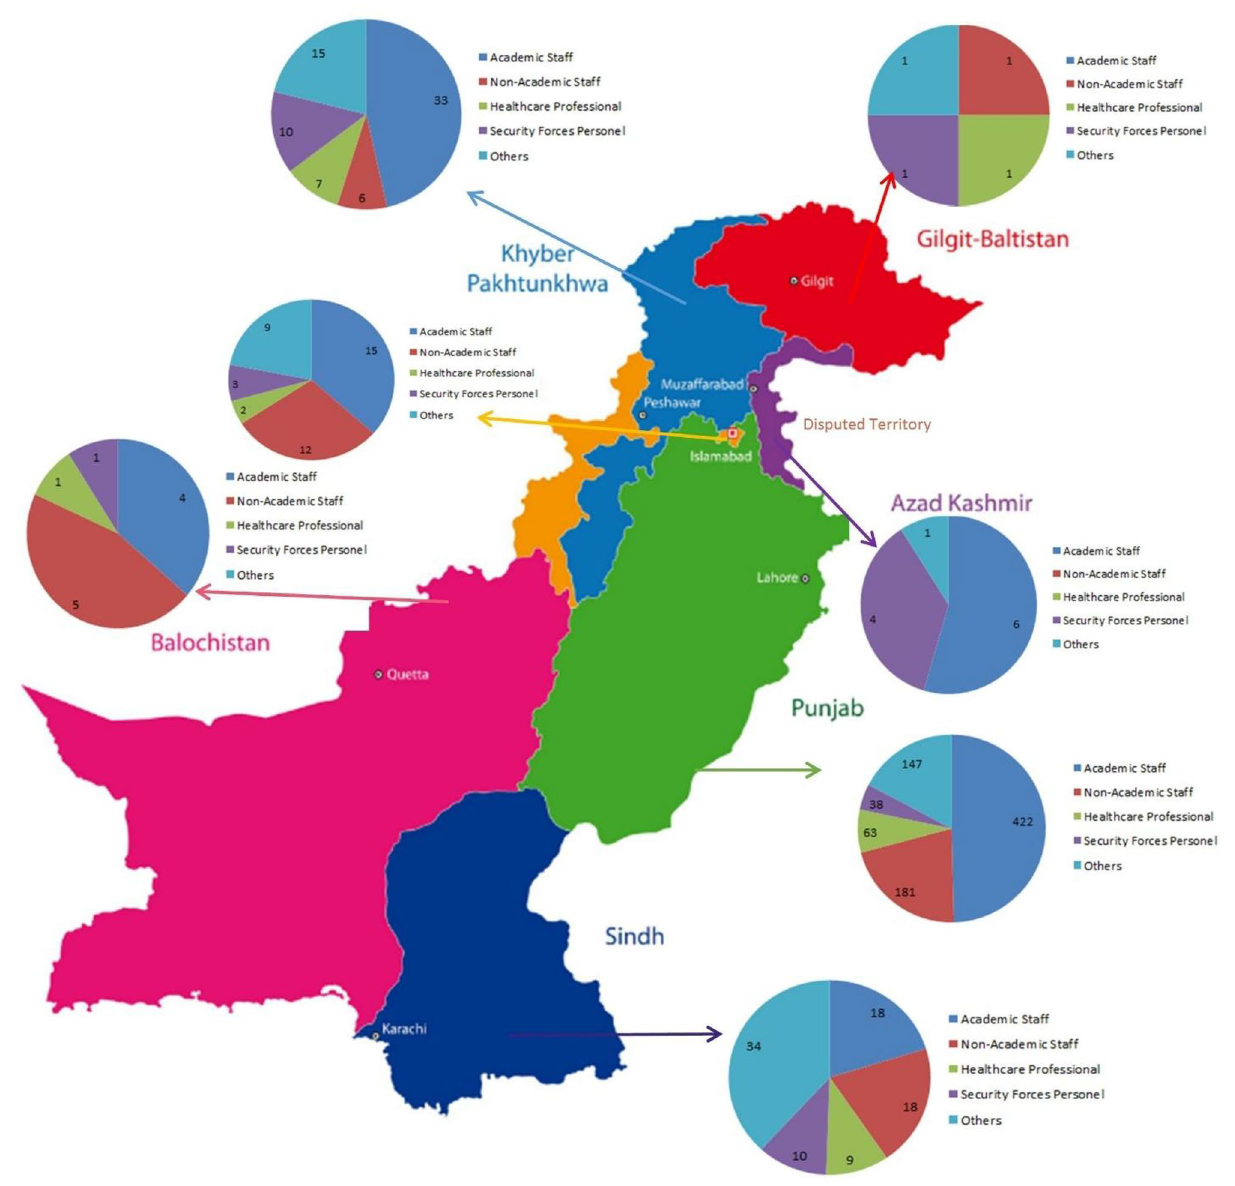
Figure 5. Respondents’ distribution province wise. (http:// clipa rt- libra ry. com/ clipa rt/ pc5oX eaoi.